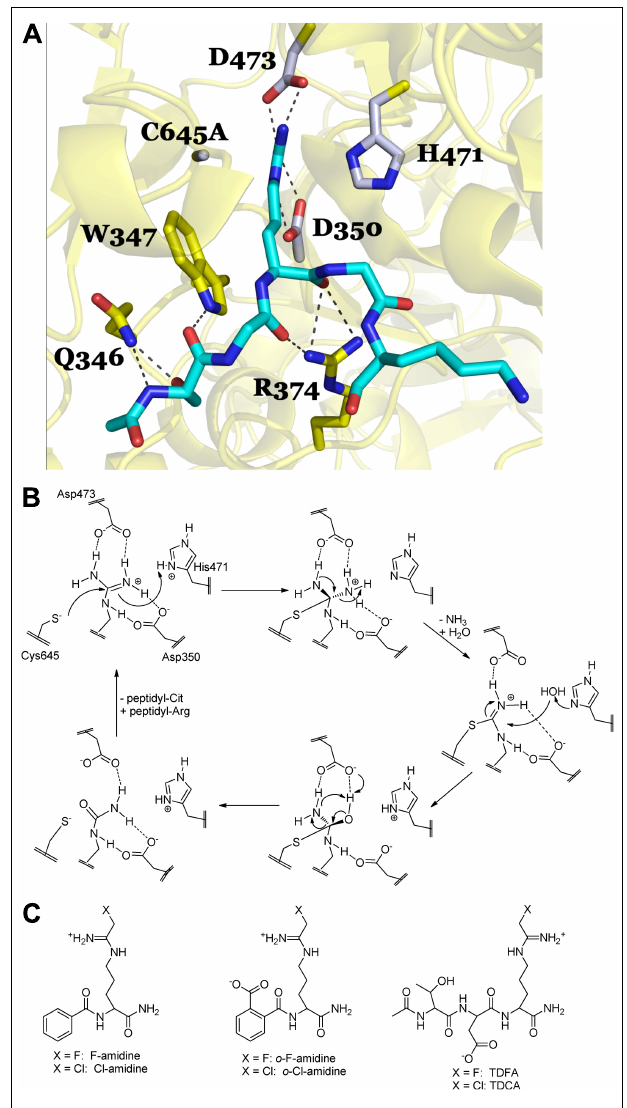
FIGURE 2 | (A) PAD4 in complex with Histone H4 1–5 (SGRGK). PAD4 active site residue side chains are colored gray (D350, H471, D473, C645A) and residues that are involved in binding the H4 1–5 backbone and S1 are colored yellow (Q346,W347, R347). N-terminally acetylated H4 1–5 is shown in cyan with Arginine 3 bound in the PAD4 active site. Polar residue interactions between PAD4 and H4 1–5 are indicated by dashed lines.The mutation of the active site cysteine residue (C645) to an alanine (C645A) was necessary to achieve substrate binding in the crystal structure as described in Arita etal. (2006). Figure was created from the structure filed under PDB code 2dey. (B) Proposed catalytic mechanism for PAD4. (C) Haloacetamidine-based inhibitors targeting the PAD